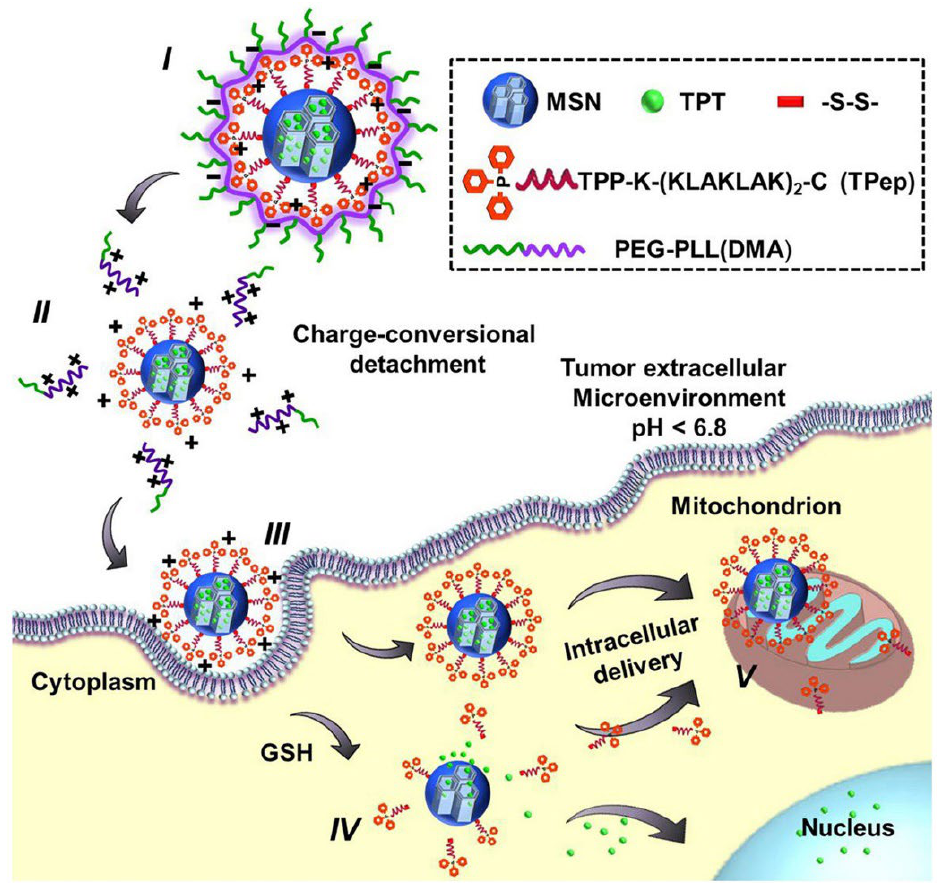
Figure 4. Schematic illustration of the TACMAA-based DePEGylation of MSN-TPep/PEG-PLL(DMA) in weakly acidic TME, and mitochondria-targeting and controlled intracellular drug release. Reprinted from Ref. [84], under the terms of the Creative Commons Attribution License. I: The structure of MSN-TPep/PEG-PLL(DMA); II: TACMAA-based charge reversal for DePEGylation; III: Positive charge-based cancers targeting; IV: GSH triggered TPT release intracellular; V: Mitochondria-targeted therapy.